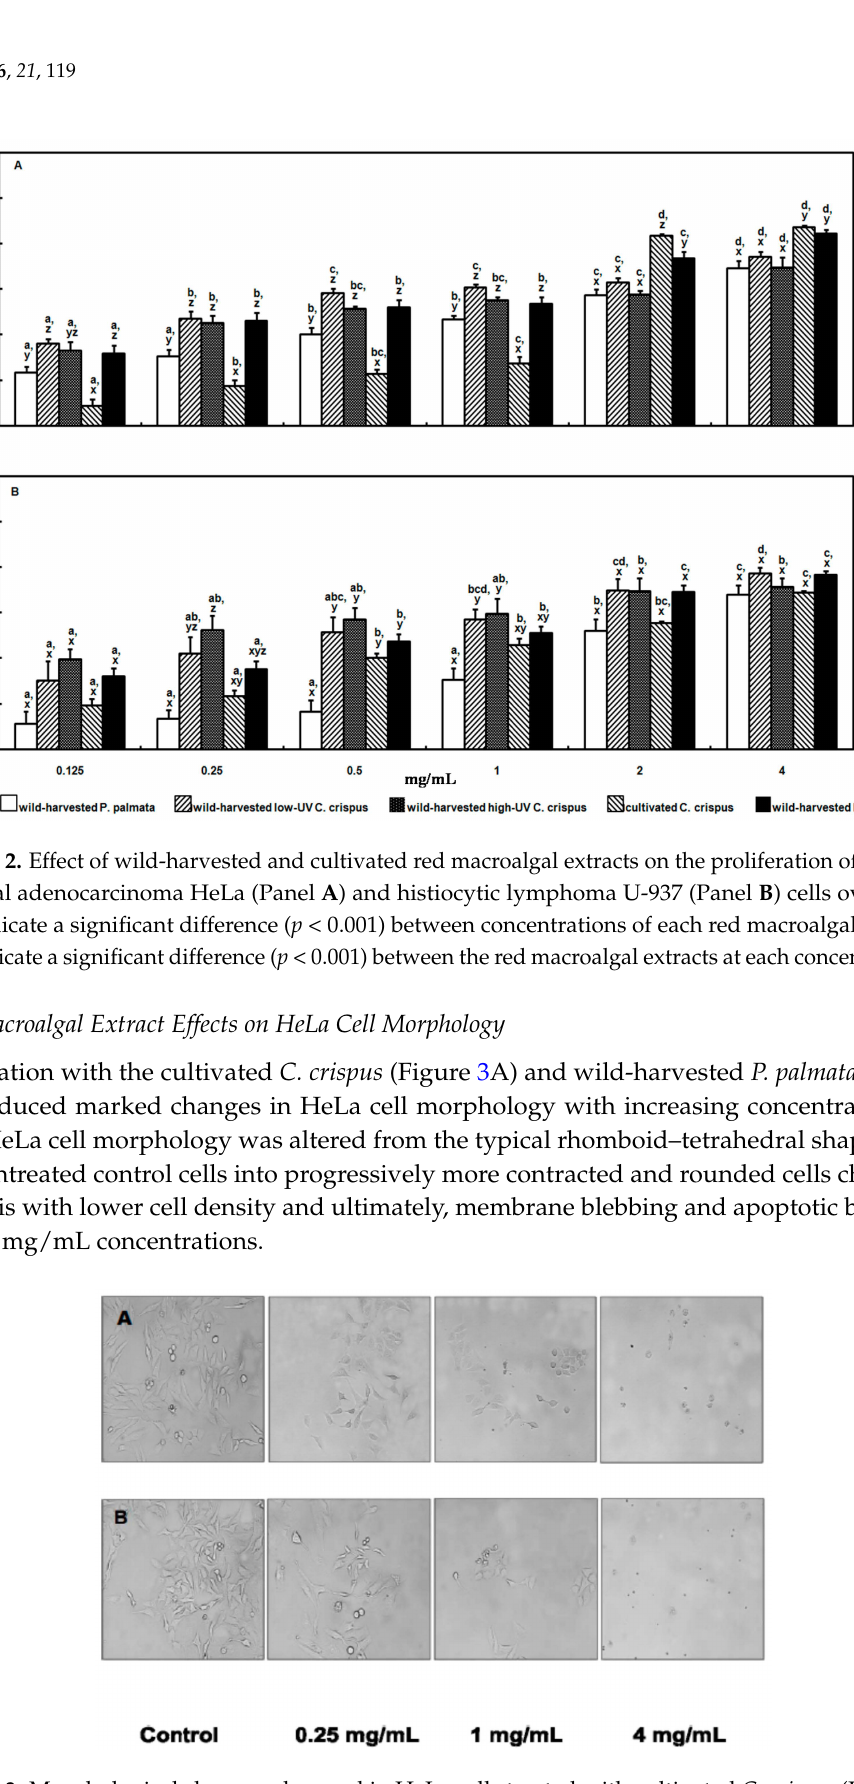
Figure 3. Morphological changes observed in HeLa cells treated with cultivated C. crispus (Panel A ) and wild-harvested P. palmata extracts (Panel B ) using an inverted microscope (200 ˆ